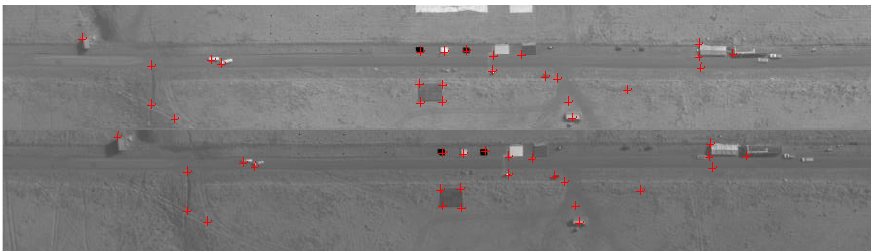
Figure 15. An example for the manually selected matched points from the 2D temperature maps of LWIR1 a – LWIR1 b . Note that the images are rotated horizontally. (+indicates the selected points for matching.).